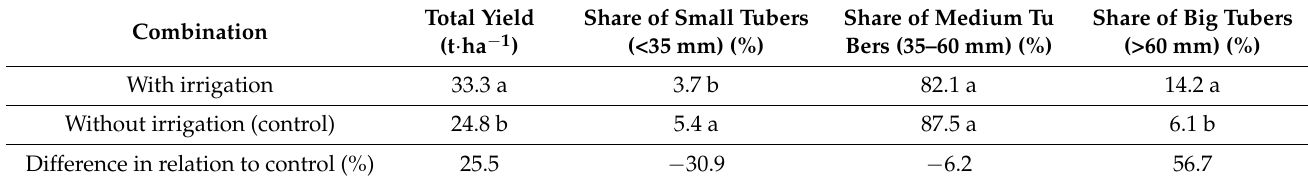
Table 5. Influence of irrigation on tuber yield and tuber size